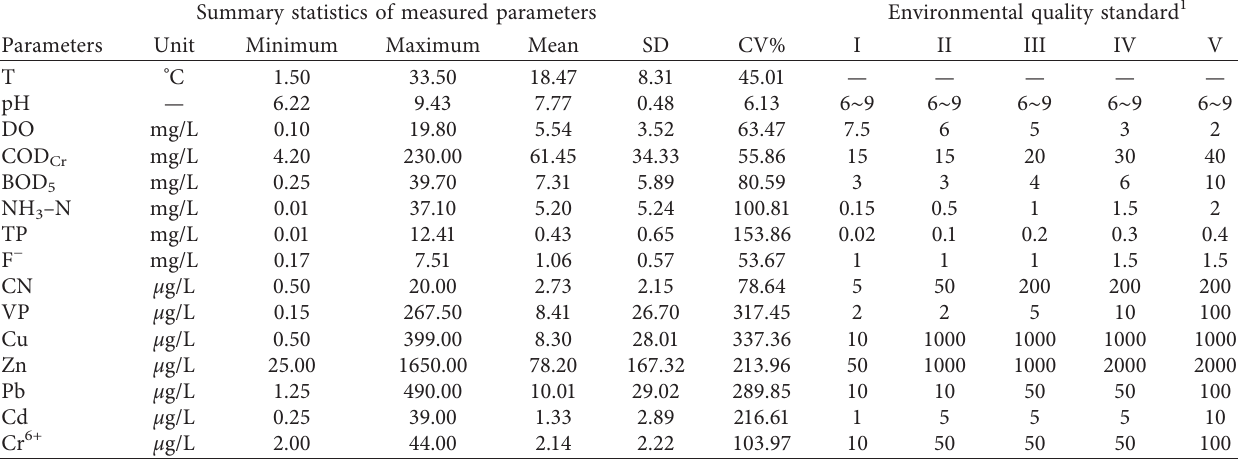
Table 2: Statistics of the measured parameters and the national standards for surface water